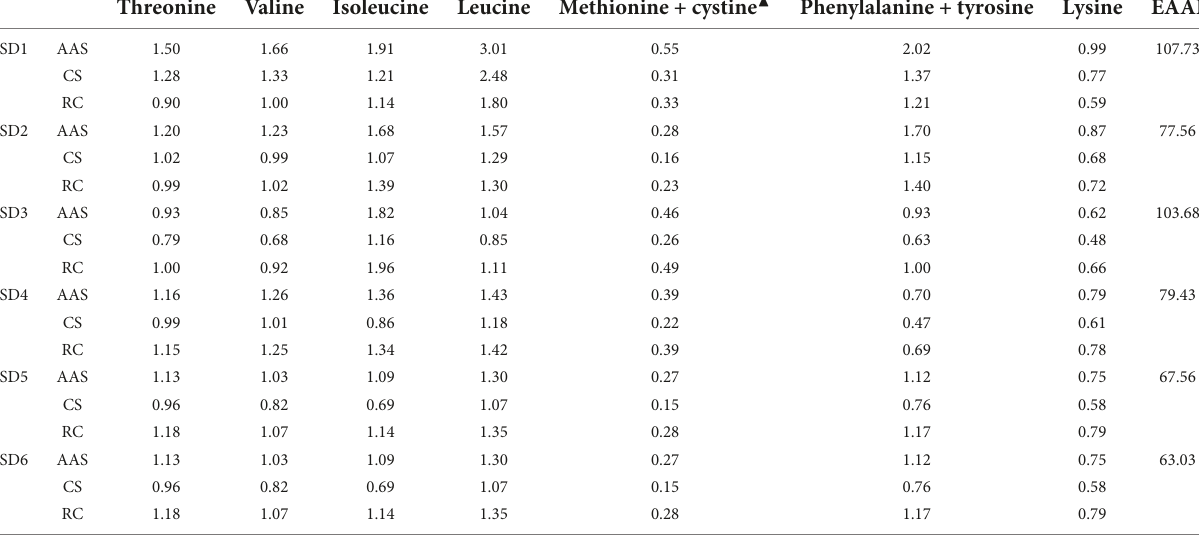
TABLE 6 Comparative nutrition indices of different sweet salad dressings and the adult essential amino acid (EAA) model recommended by FAO/WHO (19).